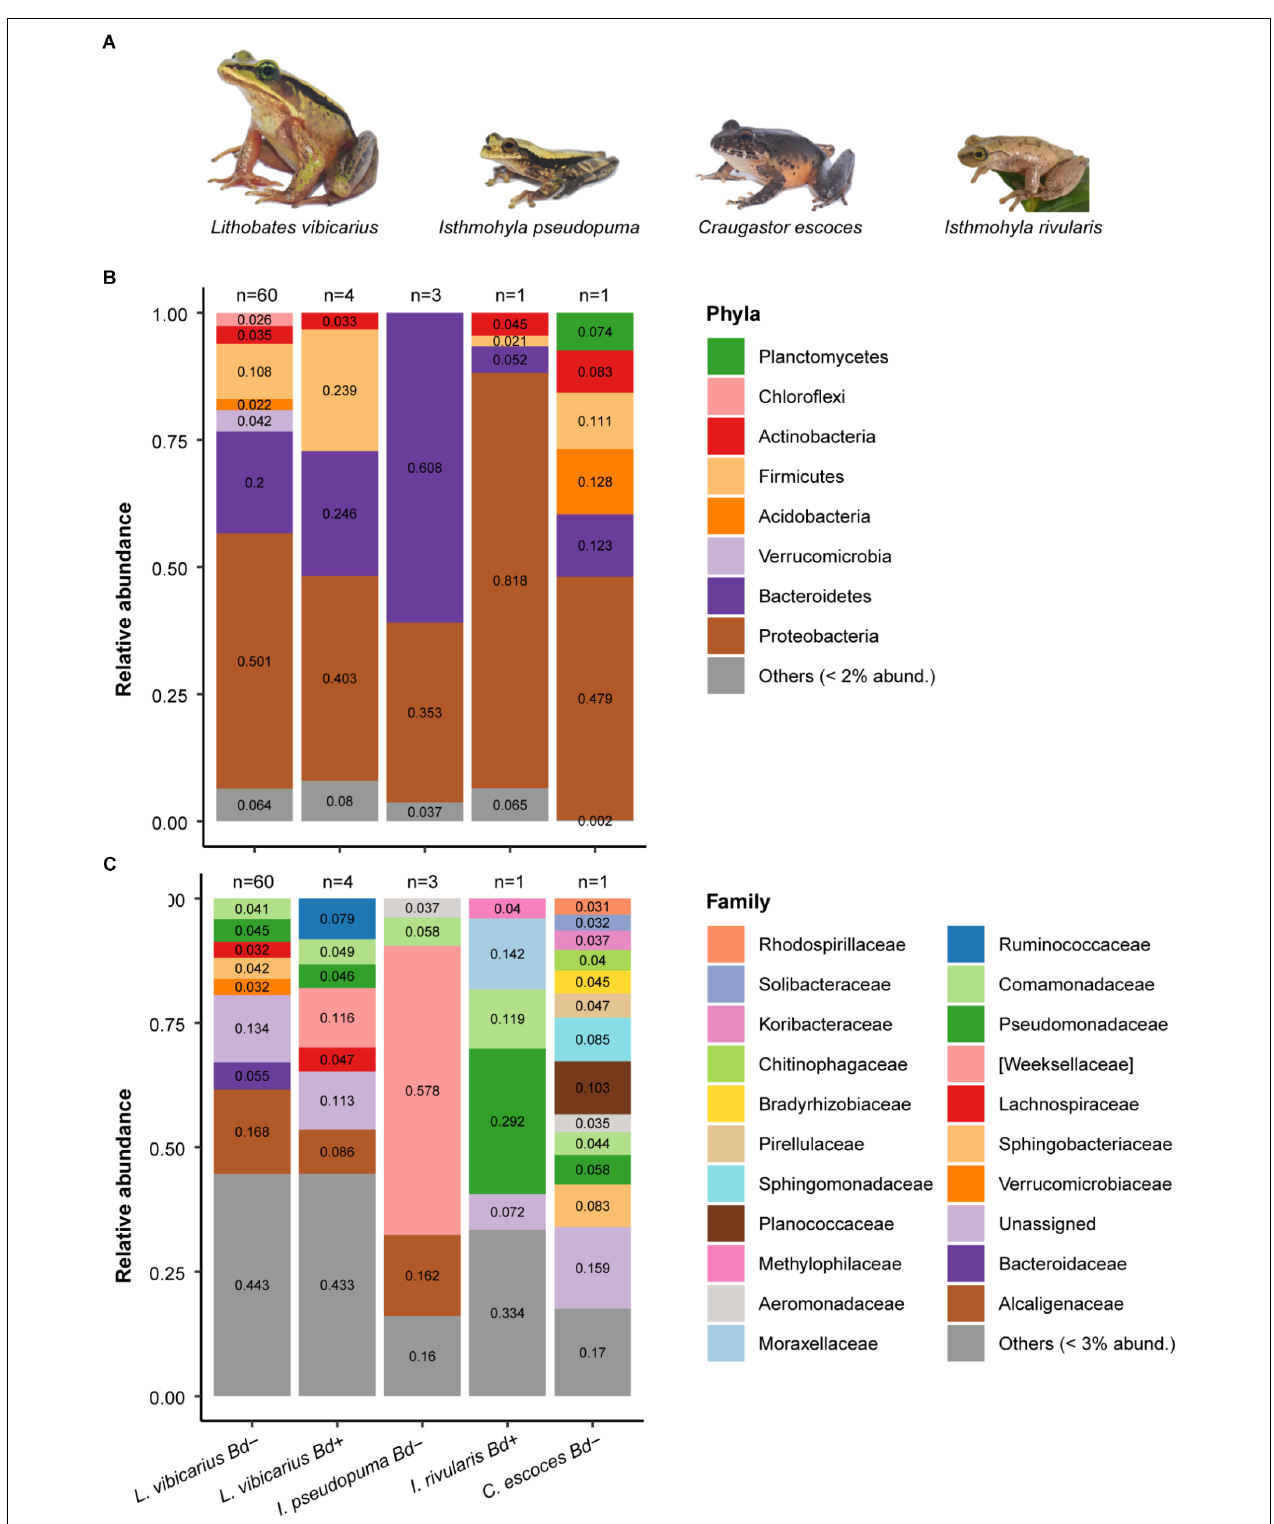
FIGURE 1 | Skin microbiome of four adult frog species grouped by Bd -infection status. (A) Neotropical montane frog species used for studying the host-associated skin microbiome (B) Relative abundance of skin bacterial taxa at the phylum level across species. Rare ASVs (relative abundances < 2%) were clustered together. (C) Relative abundance of skin bacterial taxa at the family level across species. ASVs with relative abundances < 3% were clustered together.